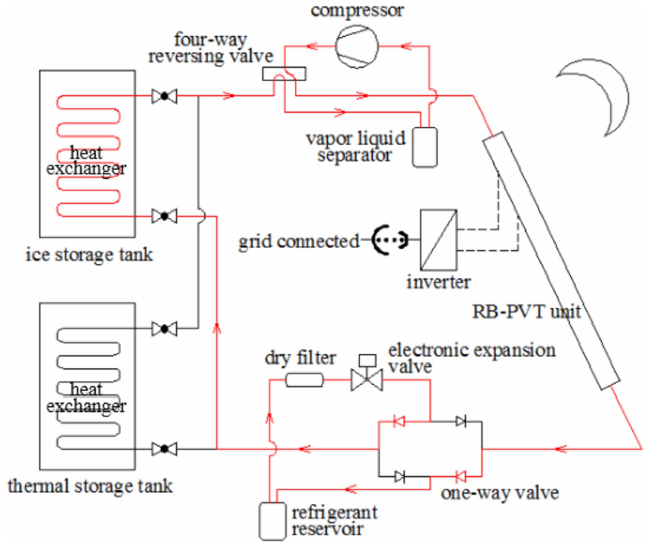
Figure 14. Schematic diagram of the proposed PV/T heat pump system on refrigeration mode